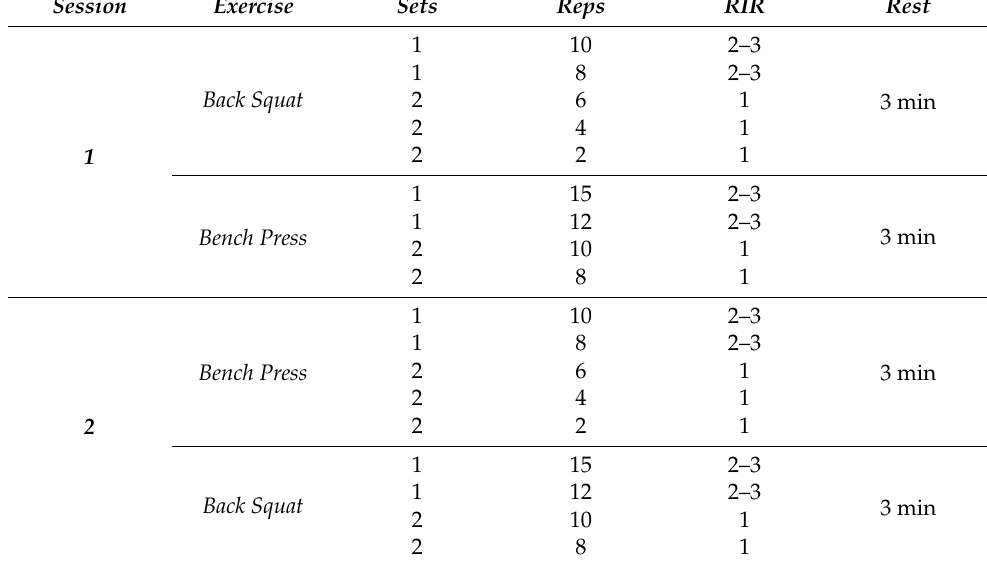
Table 4. Training sessions per week. RIR = repetitions in reserve